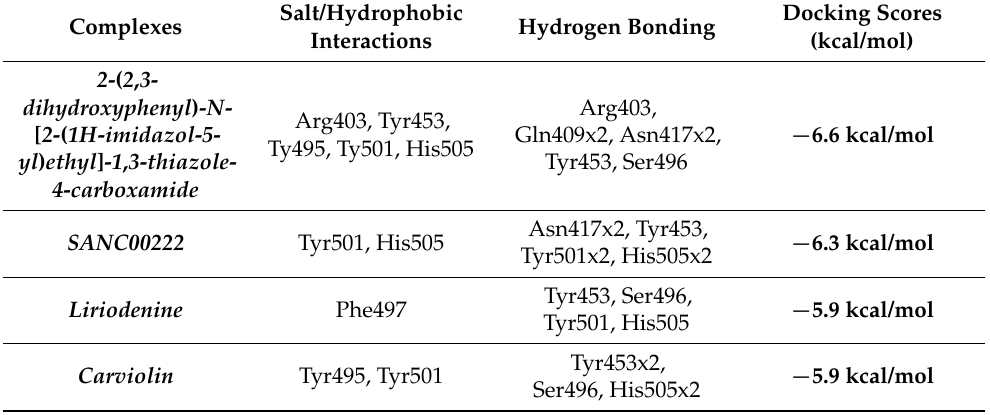
Figure 4. Interaction patterns of Liriodenine from EANDB and Carviolin from NANCDB with RBD. ( A ) shows the binding mode of Liriodenine, while ( B ) shows the binding pattern of Carviolin. Table 1. Top hits from different databases along with the interaction types, including hydrophobic, hydrogen bonding, and docking scores.